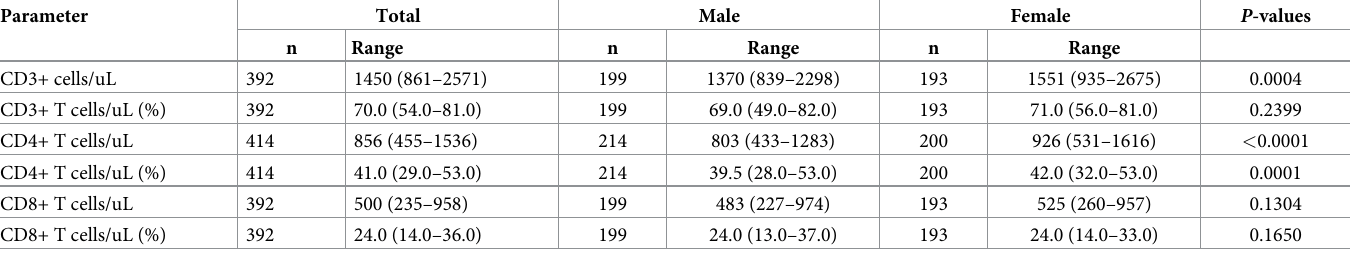
Table 3. Lymphocytes subset reference values (median and 2.5 th —97.5 th percentiles) derived from healthy adults at high-risk for HIV in